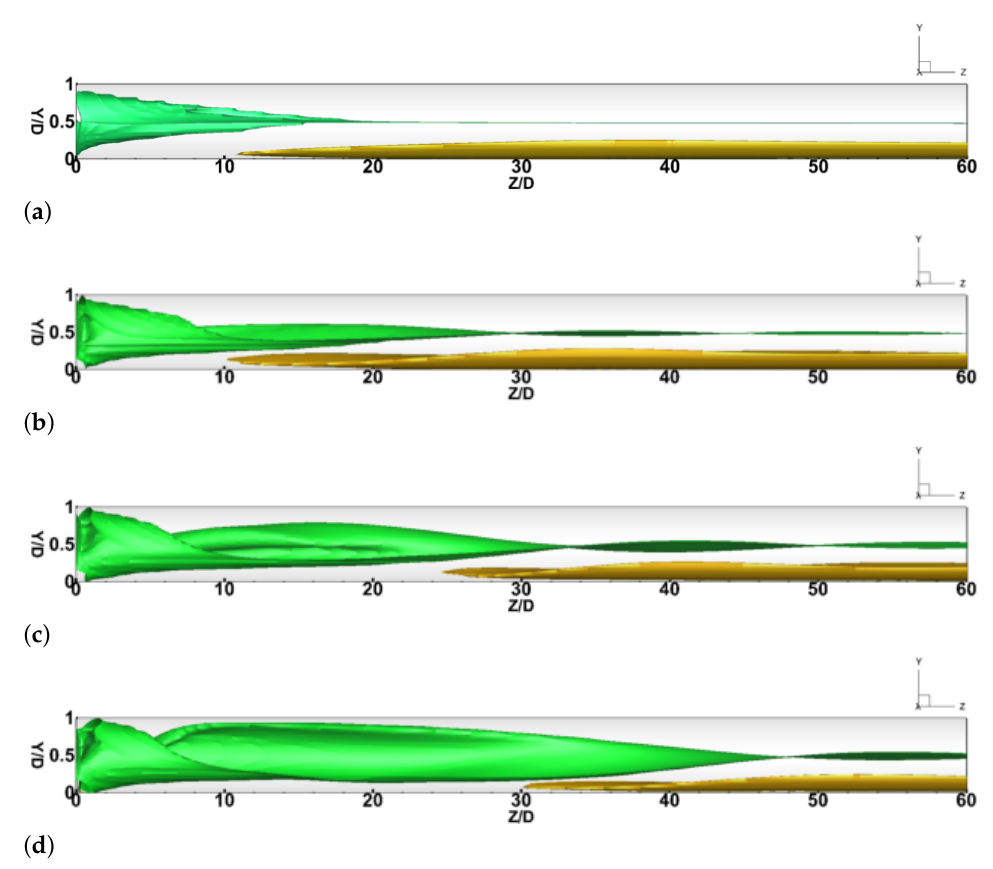
Figure 5. Iso-surface contours of mixture solid volume fraction: ( a ) SR = 0; ( b ) SR = 0.1; ( c ) SR = 0.25; ( d ) SR = 0.5. φ s = 0.35 (brown color) and φ s = 0.2 (green